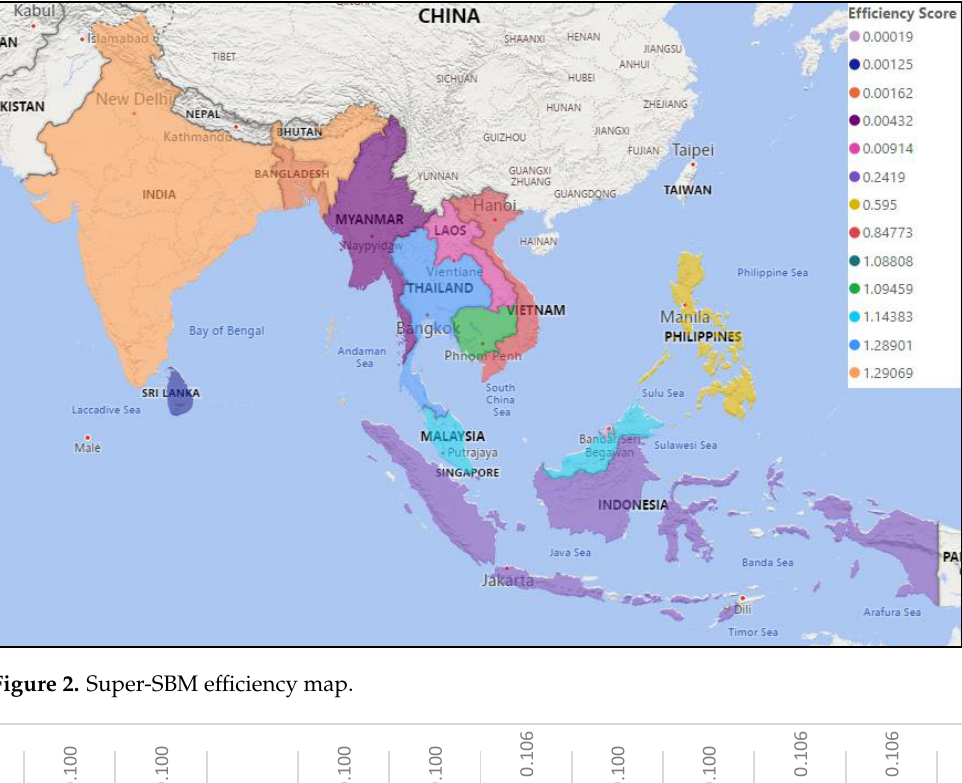
Figure 2. Super-SBM efficiency map.